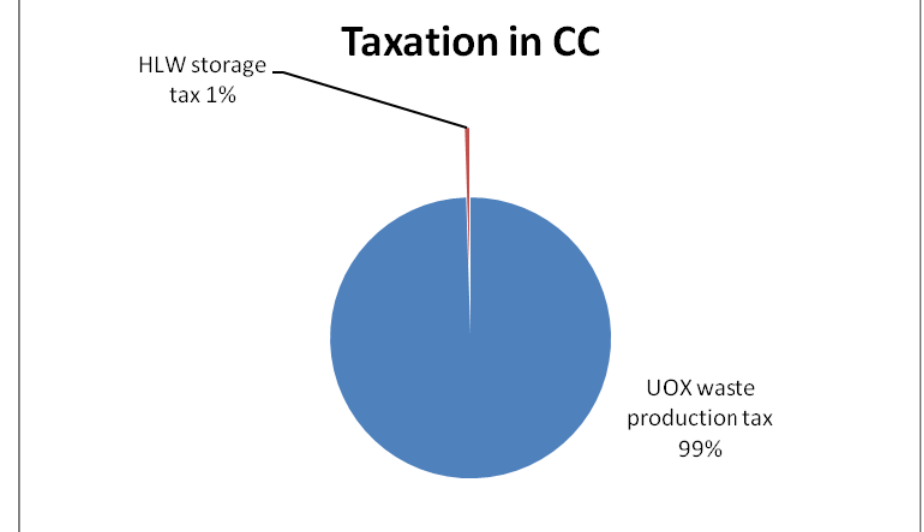
Figure 5. Each tax contribution to the total taxation in the closed cycle.